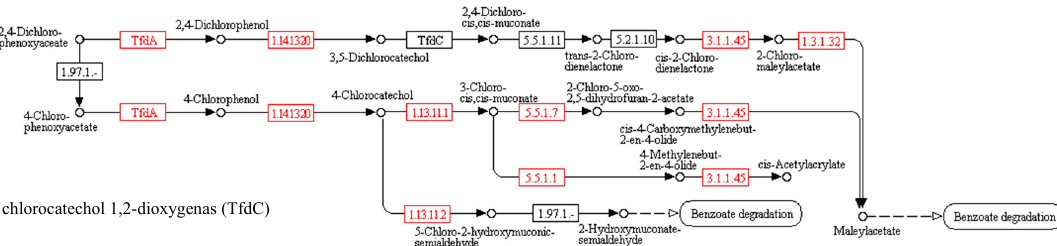
Figure 4. List of orthologs which participated in the MCPA and 2,4-D biodegradation process included in the KEGG (Kyoto Encyclopedia of Genes and Genomes) database.